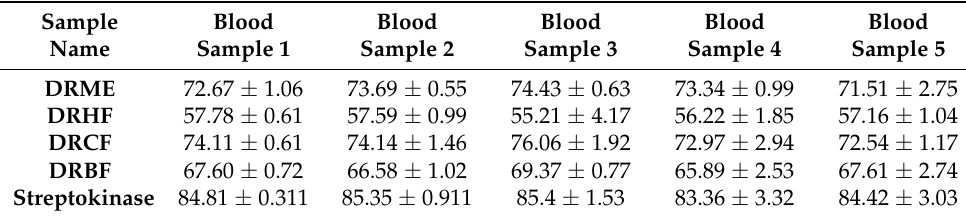
Table 4. Thrombolytic activity of the extract/fractions of D. reflexa and streptokinase in five blood